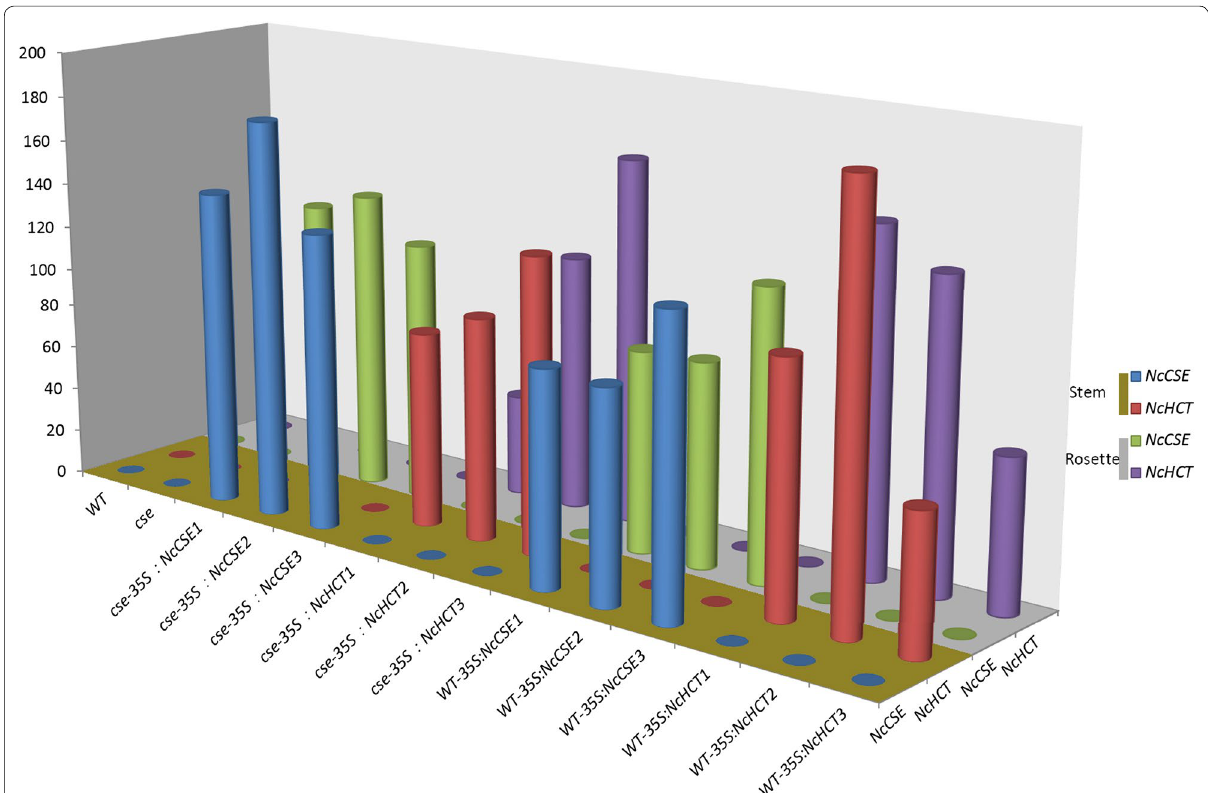
Fig. 2 Relative expression levels of the exogenous genes NcCSE and NcHCT in transgenic lines and in wild-type and cse mutant